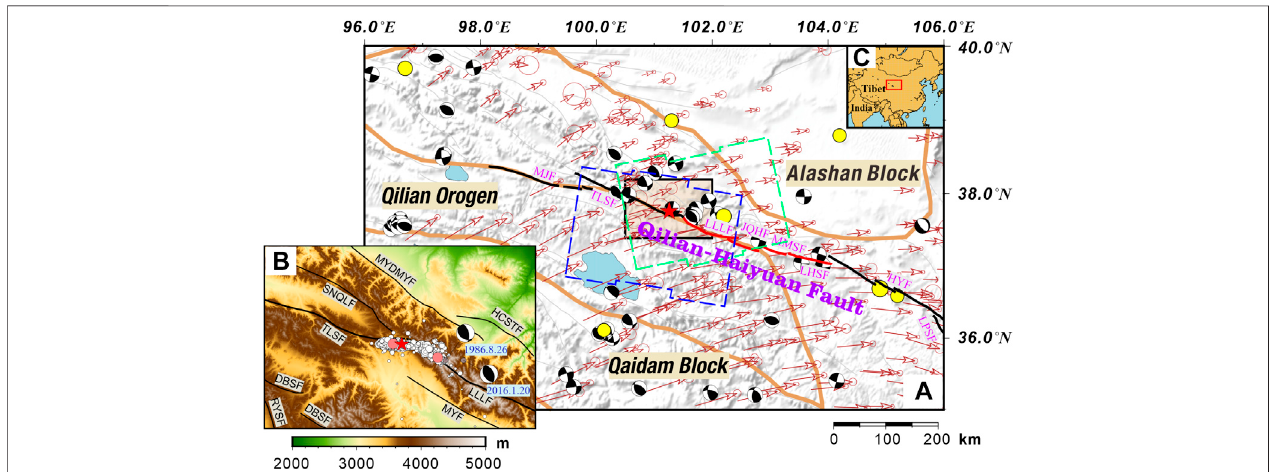
FIGURE 1 | Tectonic backgrounds of the Menyuan Ms 6.9 earthquake. (A) The green and blue dashed rectangles represent the data coverage of ascending and descending orbits of Sentinel-1 satellites, respectively; the black rectangle represents the scope of the study area. The black and red solid lines constitute together the Qilian-Haiyuan Fault, and the latter isseen asthe Tianzhu Gap (Gaudemer et al., 1995).The yellow circles representhistorical earthquakes withsurface wave magnitude (Ms) larger than 7 since 1900 (data from Sichuan Earthquake Administration). Black beach balls represent focal mechanisms of M ≥ 5.0 events (Global CMT, since 1976). Brown arrows represent the GPS velocity fi eld with respect to the Eurasian frame (Wang and Shen, 2020). The red star represents the Ms 6.9 earthquake. The backgroundimageisDEMfromSRTM(FarrandKobrick,2000). (B) Topographyofthestudyarea[blackboxinFigure (A) ]andaftershockdistribution.Themainshockis marked by the red star. Pink circles represent two Ms ≥ 5.0 aftershocks (Yang et al., 2022); black beach balls represent the focal mechanisms of two Ms 6.4 Menyuan earthquakesin1986and2016.Thesolidblacklinerepresentsthesurfacefaulttrace(Xuetal.,2016). (C) Geographicallocationofthestudyarea.Theredboxmarksthe extentof fi gure (A) .MJF:Muli-JiangcangFault,TLSF:TuolaishanFault,LLLF:LenglonglingFault,JQHF:JinqiangheFault,MMSF:MaomaoshanFault,LHSF:Laohushan Fault, HYF: Haiyuan Fault, LPSF: Liupanshan Fault, SNQLF: Sunan-Qilian Fault, MYDMYF: Minyue-Damaying Fault, HCSTF: Huangcheng-Shuangta Fault,